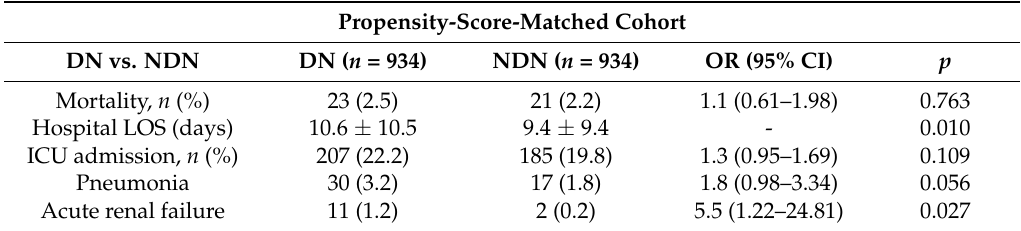
Table 3. Comparison of the outcomes in the selected propensity-score-matched